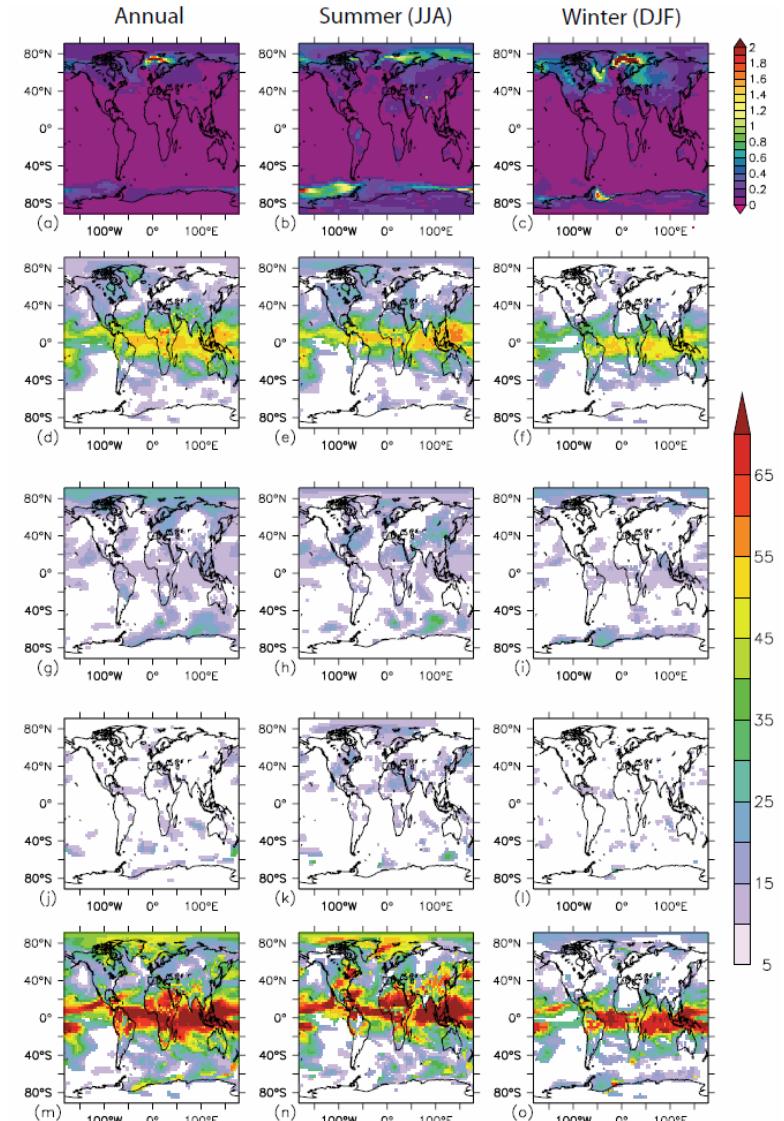
Figure 7: Percentage of temperature variance explained at first order by the terms in equation (4) corresponding to the fingerprints of solar (d, e, f), CO 2 (g, h, i), and orbital (j, k, l) forcings, and of all the forcings together (m, n, o). The white areas depicts the grid points where the fingerprints explain less than 5% of the total variance of the temperature at the given grid points, or where the regression coefficients shown on Figure 5 are not significant at 99.5%. The upper panels (a, b, c) show the temperature variance of the ten-year smoothed time series used in this study. All those diagnostics are done on annual (a, d, g, j, m), summer (b, e, h, k, n) and winter averages (c, f, i, l, o).